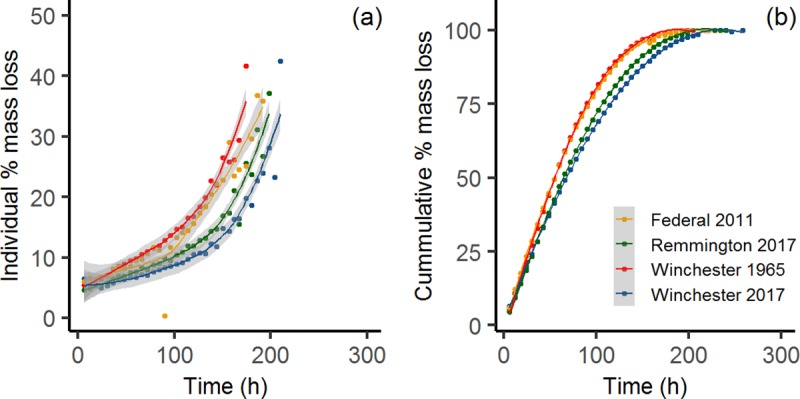
Individual and cumulative pellet mass loss of the four brand-year types of Pb shot.(a) Individual mass loss (%) and (b) cumulative mass loss (%). Solid line represents the line of best fit along and shaded areas are the 95% confidence interval (n = 6 for Federal shot, n = 3 for all other shot types).